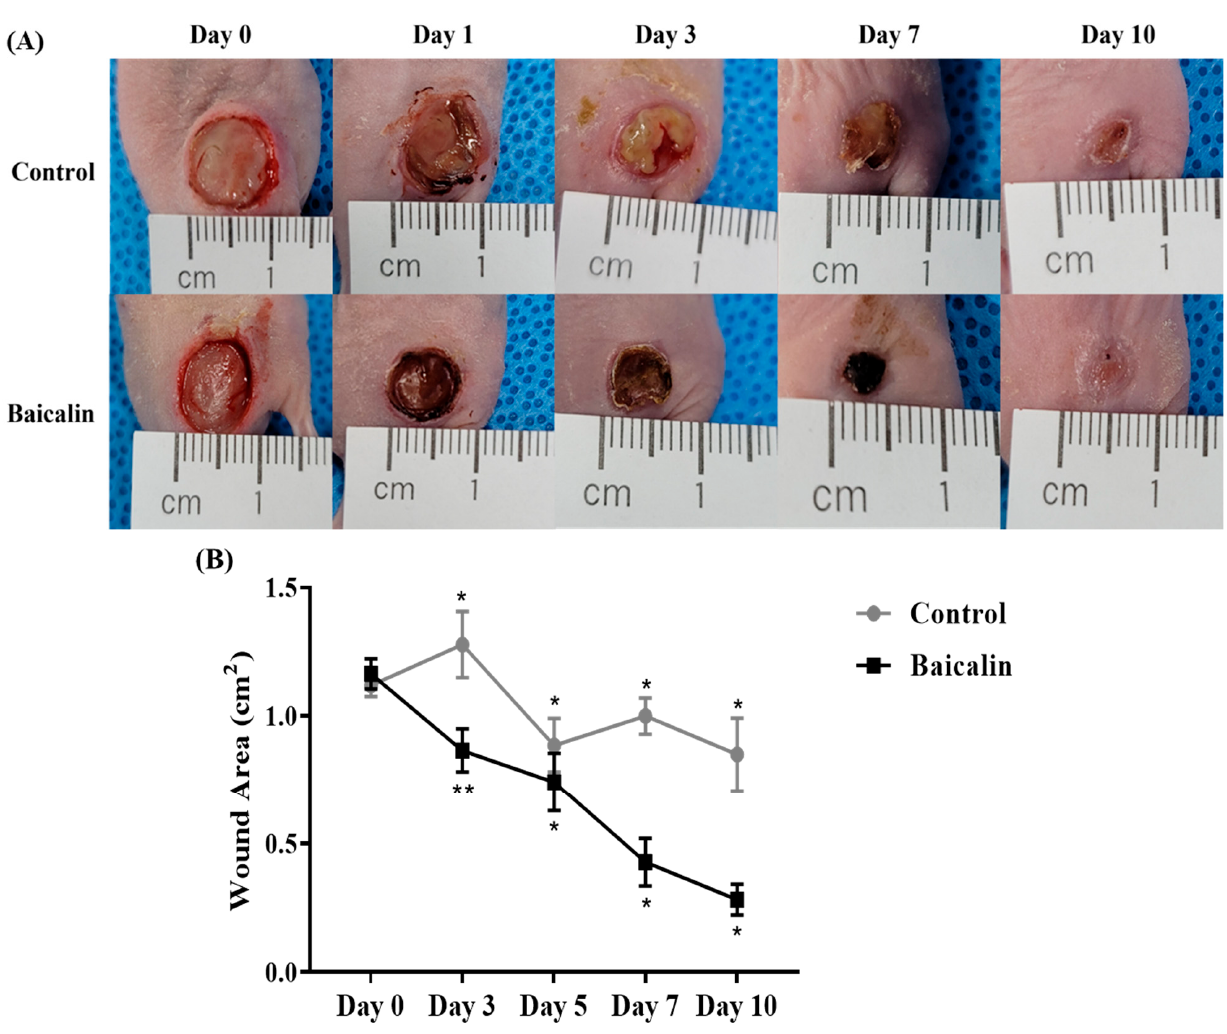
Figure 2. Topical application of baicalin accelerates the wound healing of pressure ulcers in mice. ( A ) The images show control and baicalin-treated wounds on days 0, 1, 3, 7, and 10 post-pressure ulcers in mice. ( B ) Statistical analysis of the wound area using ImageJ software. All images are representative of three independent experiments ( n = 18). * p < 0.05, ** p < 0.01.